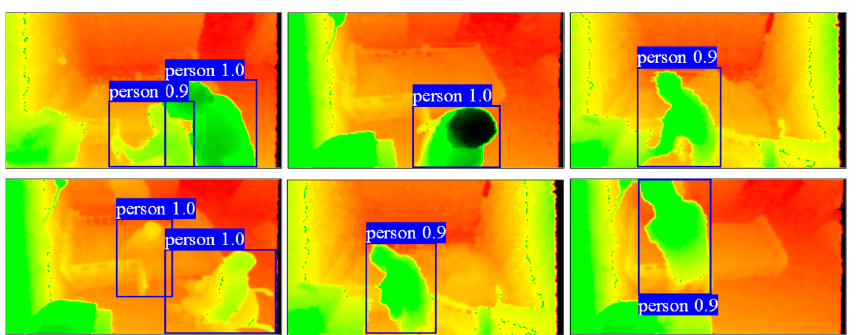
Figure 4. Results of the colorization process.